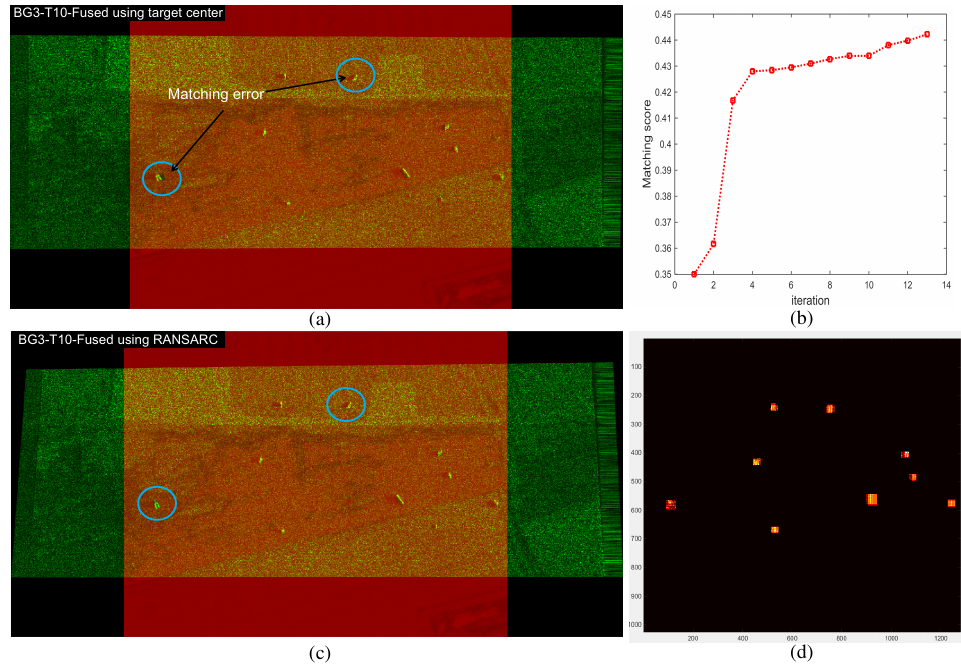
Figure 25. SAR and IR registration results for the background ID3 using BG3-T10-IR/SAR images: ( a ) initial automatic registration using a brute-force search from the detected target centers; ( b ) registration optimization curve of the proposed RANSARC; ( c ) refined registration results; ( d ) detected region overlap by the estimated